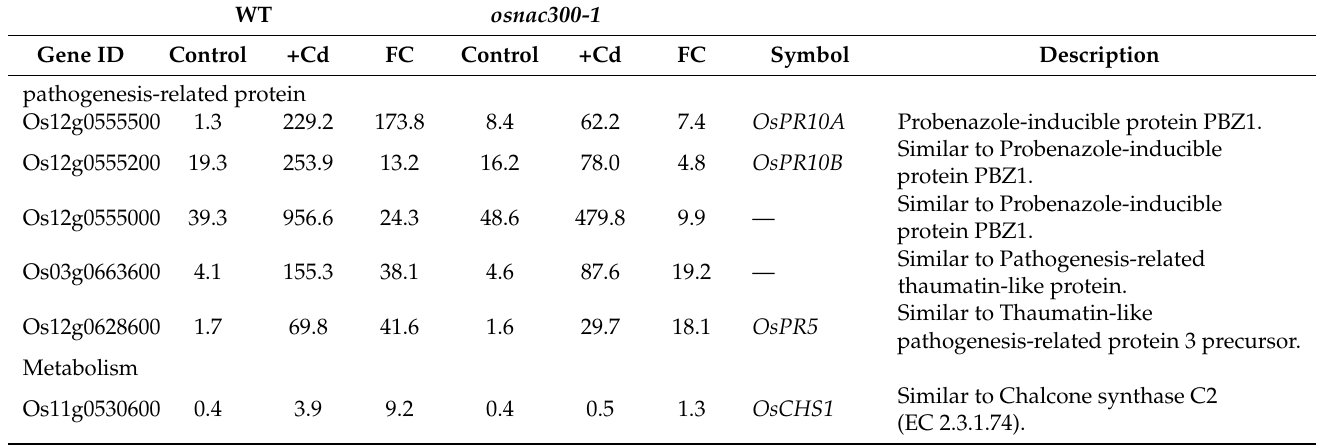
Table 1. Differential expression (in roots) of genes was affected by